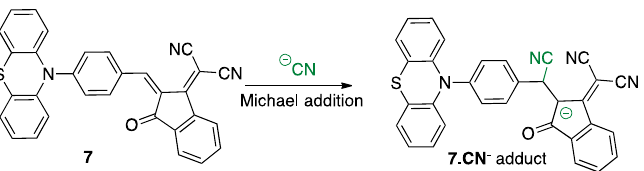
Figure 6. Nucleophilic conjugate addition (Michael addition reaction) of cyanide anion on chromo- phore 7 in CH 3 CN affording the adduct 7.CN − .